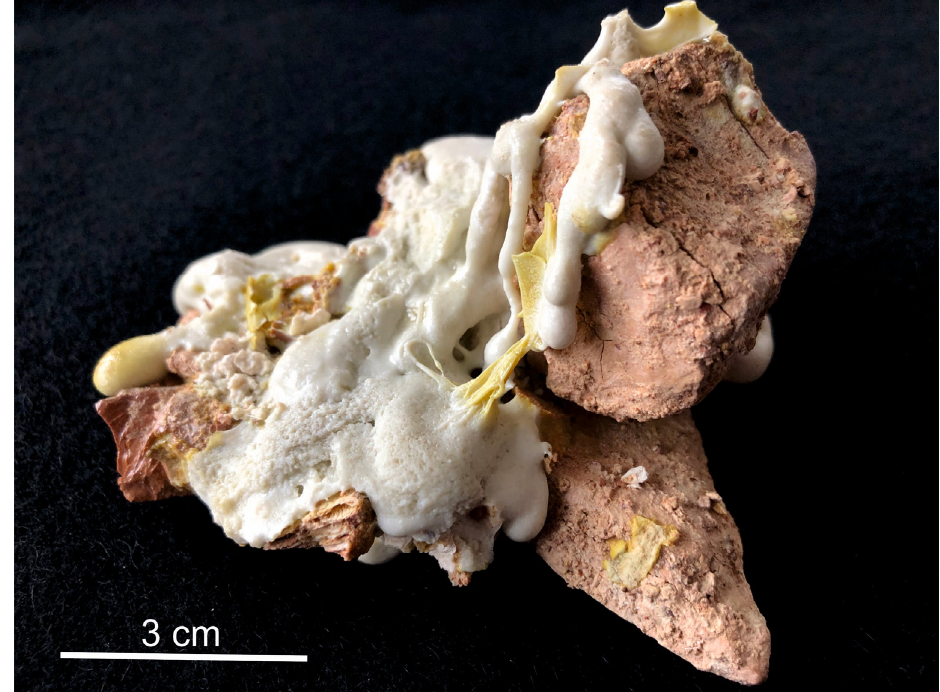
Figure 3. Dripstone aggregates of godovikovite generated from the semi-liquid masses.